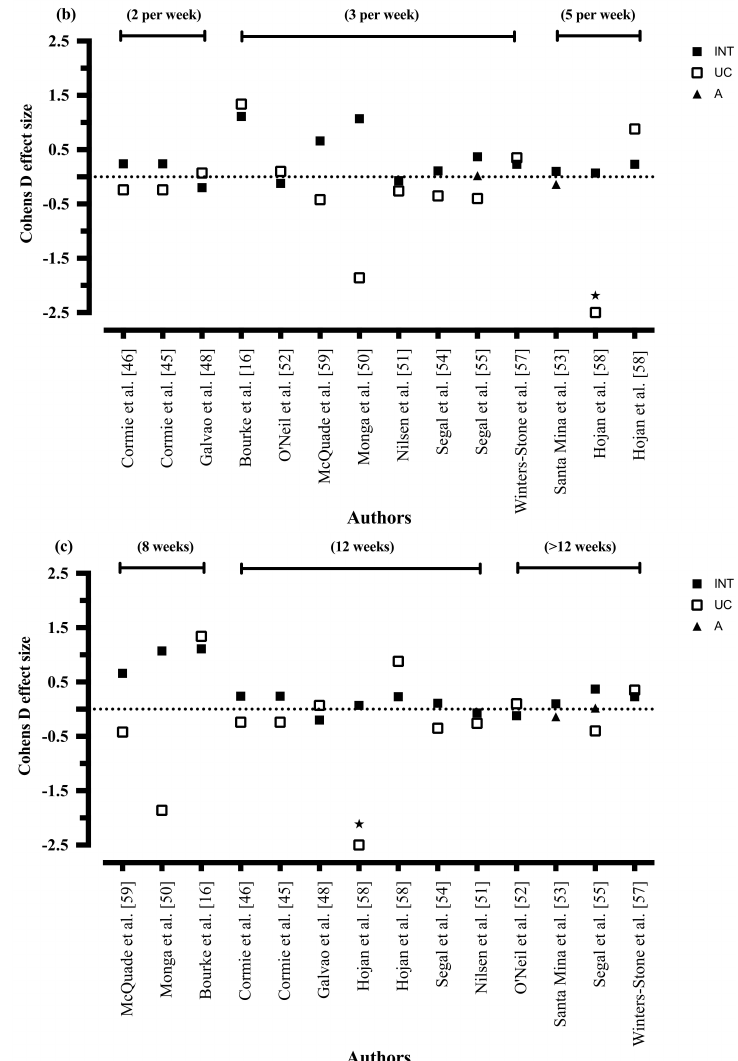
Figure 2. ( a ) Cohens D effect size of exercise mode on cancer-related fatigue; ( b ) Cohens D effect size of exercise frequency on cancer-related fatigue; ( c ) Cohens D effect size of exercise duration on cancer-related fatigue (A = aerobic exercise, R = resistance training, INT = intervention, UC = usual care, b = second measure of cancer-related fatigue, * = effect size of −